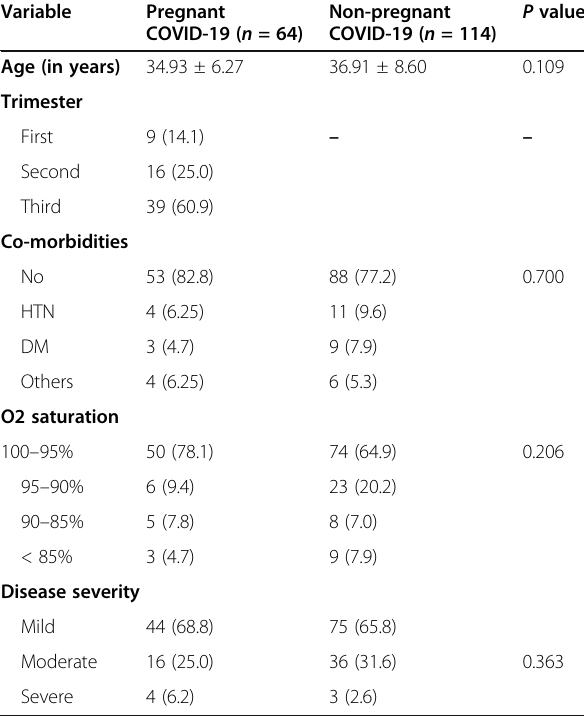
Table 1 Comparison between the pregnant COVID-19 and non- pregnant COVID-19 patients regarding their